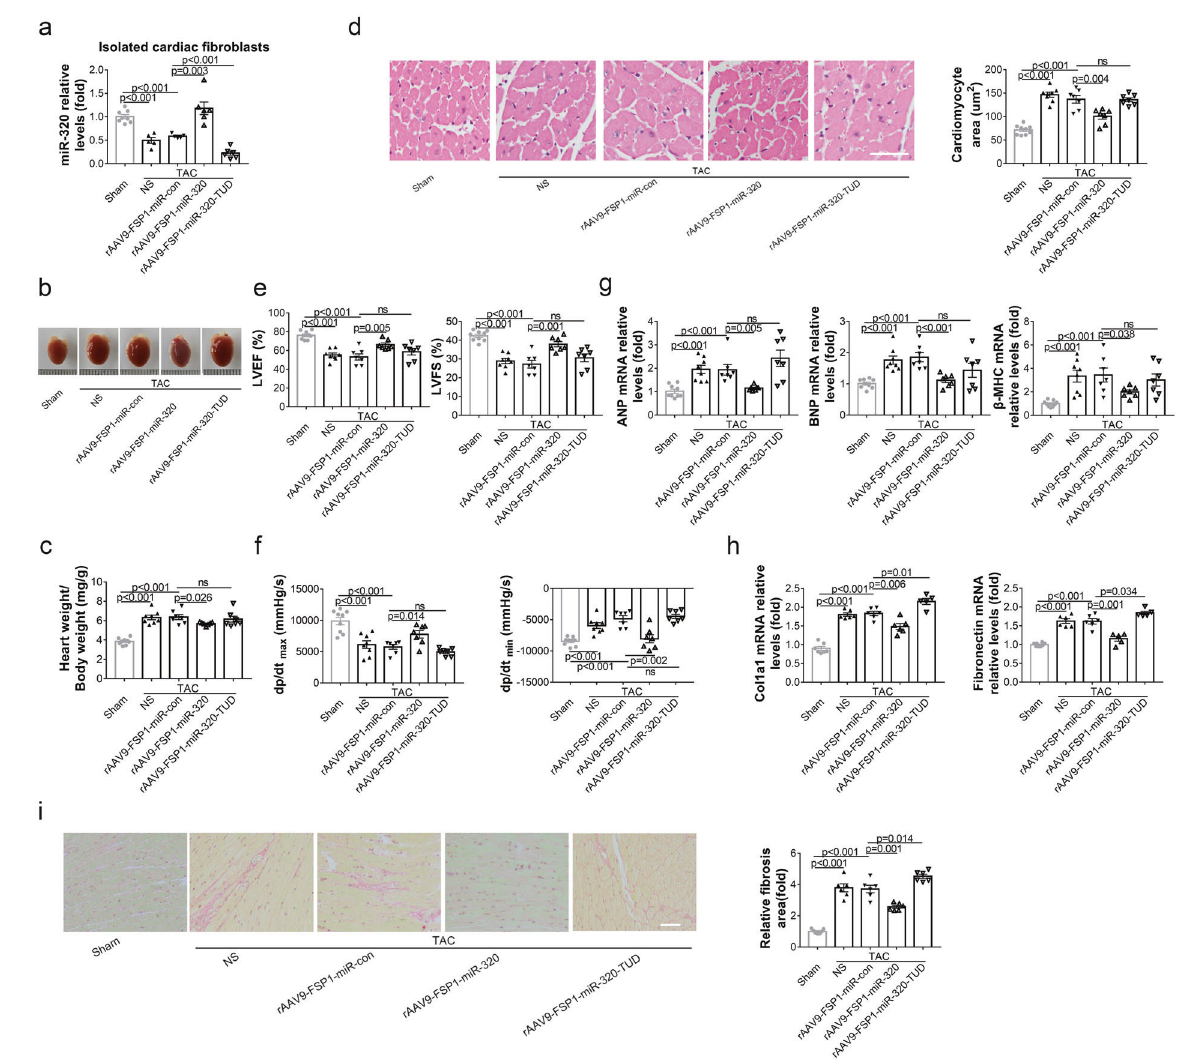
Fig. 4 Overexpression of miR-320 in CFs mitigated HF in vivo. a Relative expression of miR-320 in isolated CFs detected by real-time PCR. b Representative gross morphologies of the hearts in mice subjected to different treatments. c The ratios of heart weight to body weight in mice with diverse treatments. d H&E staining represented the areas of CMs (left). Scale bars, 50 µm. The areas of CMs were analyzed by Image- Pro Plus (right). e Echocardiography analysis of LVEF% and LVFS%. f Hemodynamic parameters were measured by the Millar cardiac catheter system. g Relative mRNA expressions of cardiac hypertrophy markers in the heart tissues from diversely treated mice. h Expression levels of markers of cardiac fi brosis in the heart from mice with different treatments measured by real-time PCR. i Representative images of Sirius Red staining of the heart sections from mice with different treatments (left) and the quanti fi cation analysis of cardiac fi brosis (right). Scale bars, 50 µm. Sham ( n = 9), TAC + NS ( n = 8), TAC + rAAV9-FSP1-miR-con ( n = 7), TAC + rAAV9-FSP1-miR-320 ( n = 7), TAC + rAAV9-FSP1-miR-320-TUD ( n = 7). Data are expressed as mean ±